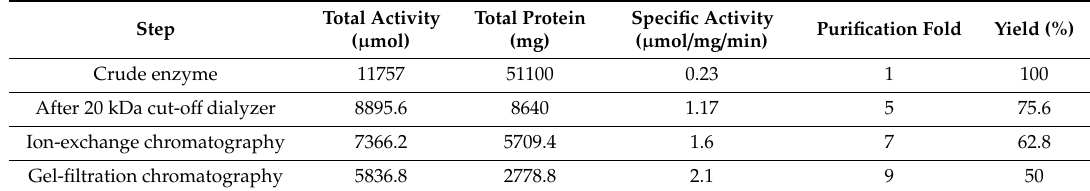
Table 2. Overall purification profile of ODC from A. terreus .